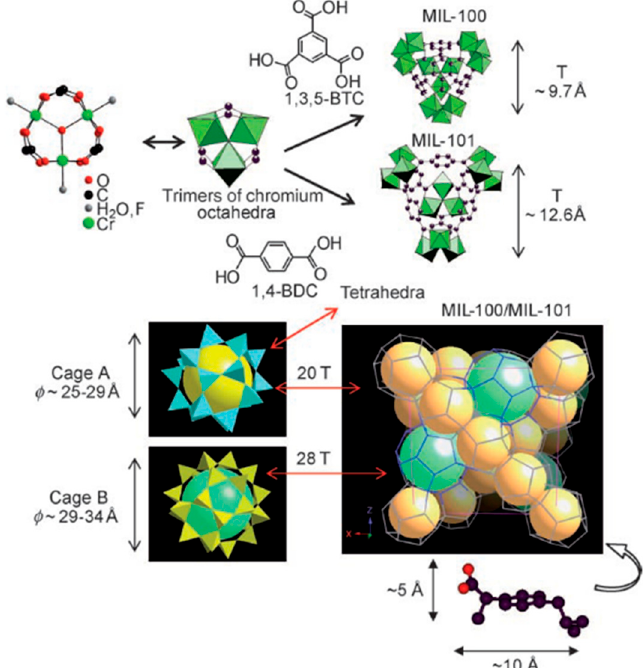
Figure 2. Schematic 3-D representation of the tetrahedra (T) consisting of trimers of chromium octahedra and 1,3,5-benzene tricarboxylic acid (BTC) or 1,4-benzene dicarboxylic acid (BDC) in MIL-101 and MIL-100, respectively ( top ) and a schematic 3-D illustration of the zeotype-architecture MIL-100 and MIL-101 ( bottom ) [53].